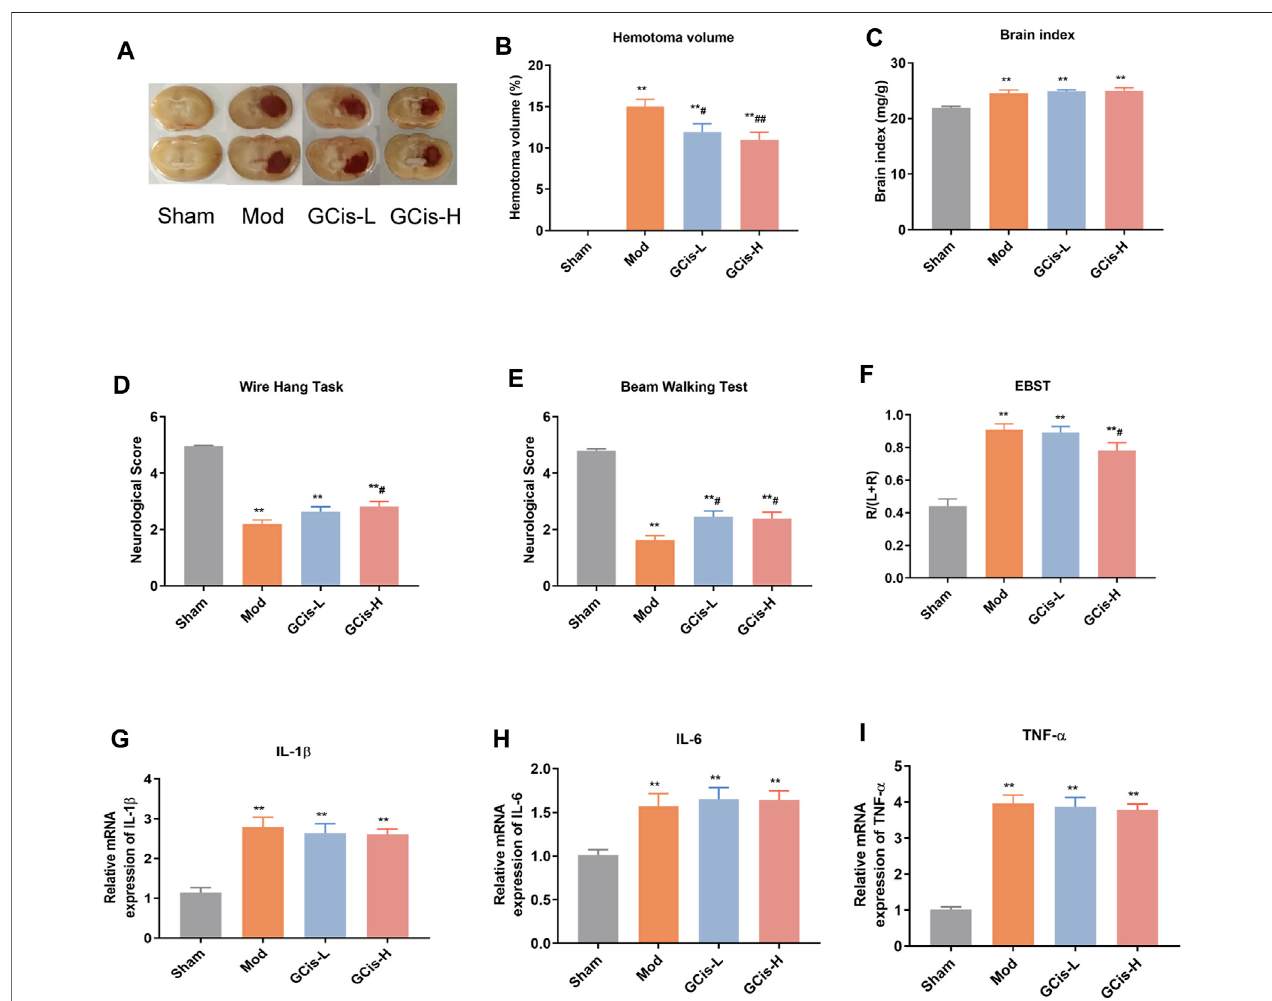
FIGURE 1| GCis formula decreased area ofICH and improved neurological function scores. (A) Areaof ICH. (B) hematoma volume ofICH, (C) brain index of ICH, (D) beam walking test, (E) wire hang test, (F) EBST, (G) IL-1 β , (H) IL-6, and (I) TNF-a in the brain. Data are shown as mean ± SEM. ** p < 0.01 compared with the sham group; # p < 0.05 and ## p < 0.01 compared with the model